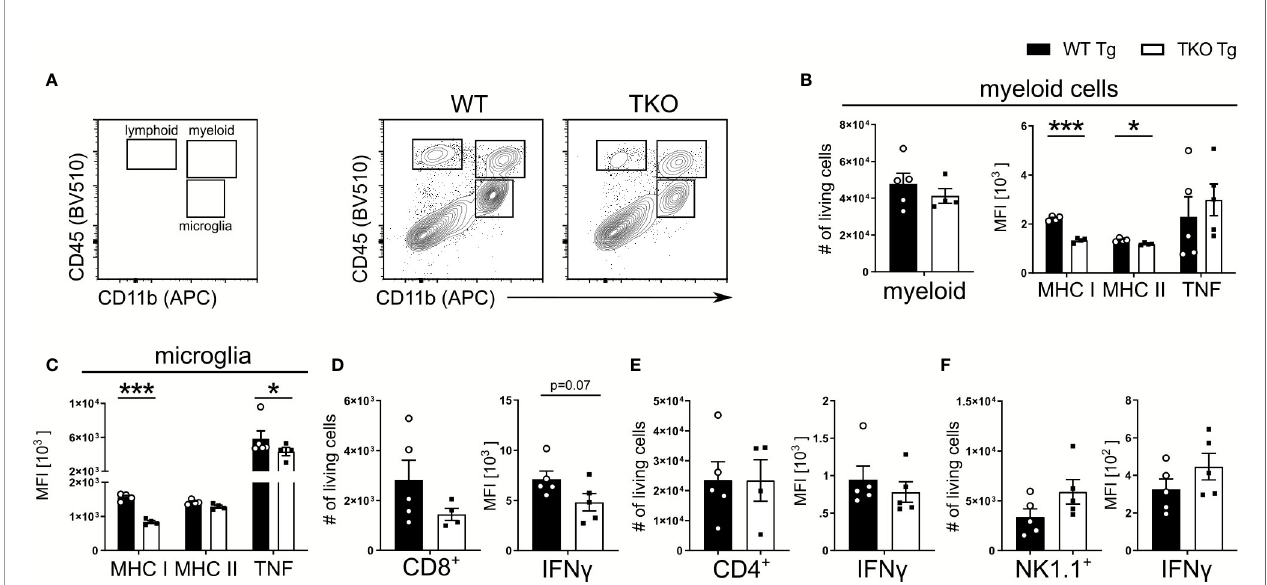
FIGURE 5 | Impaired recruitment and IFN g -dependent activation of proin fl ammatory myeloid cells in TKO mice. Immune cells were isolated from brains of T. gondii infected WT (WT Tg, n=5) and TKO (TKO Tg, n ≥ 4) mice on day 10 p.i. For the measurement of TNF and IFN g , brain cells were restimulated with TLA for 6 hours and then stained and analyzed by fl ow cytometry. Following viability staining and the basic FSC/SSC gating, single cells were chosen for further characterization. (A) Representative gating strategy using CD45 and CD11b to distinguish between microglia, myeloid cells and lymphoid cells (left plot) and representative plots from from brain tissue of infected WT (center panel) and TKO (right plot) mice. CD11b + CD45 int cells were identi fi ed as microglia and CD11b + CD45 hi were identi fi ed as recruited myeloid cells then divided into Ly6G - monocytes as depicted in Fig 2A. CD45 + CD11b - cells were divided into CD3 + CD8 + and CD3 + CD4 + T cells. CD45 + NK1.1 + cells were determined after removing CD3 + , CD8 + , Ly6C + and Ly6G + cells. Total number of cells was assessed for recruited (B) myeloid cells, (D) CD8 + T cells, (E) CD4 + T cells and (F) NK1.1 + cells. Recruited (B) myeloid cells and (C) microglia were measured for their surface expression of MHC I and MHC II as well as their production of TNF. Recruited (D) CD8 + , (E) CD4 + and (F) NK1.1 + cells had their IFN g production quanti fi ed. The expression or production of each immune marker was quanti fi ed using the MFI of their respective fl uorochromes. Data shown in A is a representative of three independent experiments. Data shown in (B – F) represents three independent experiments; symbols represent individual animals, columns represent mean values and error bars represent ± SEM. A Mann-Whitney test for comparing two groups and a 2way ANOVA followed by Fisher ’ s LSD test for comparing multiple groups was used for statistical analysis. *P < 0.05; ***P <